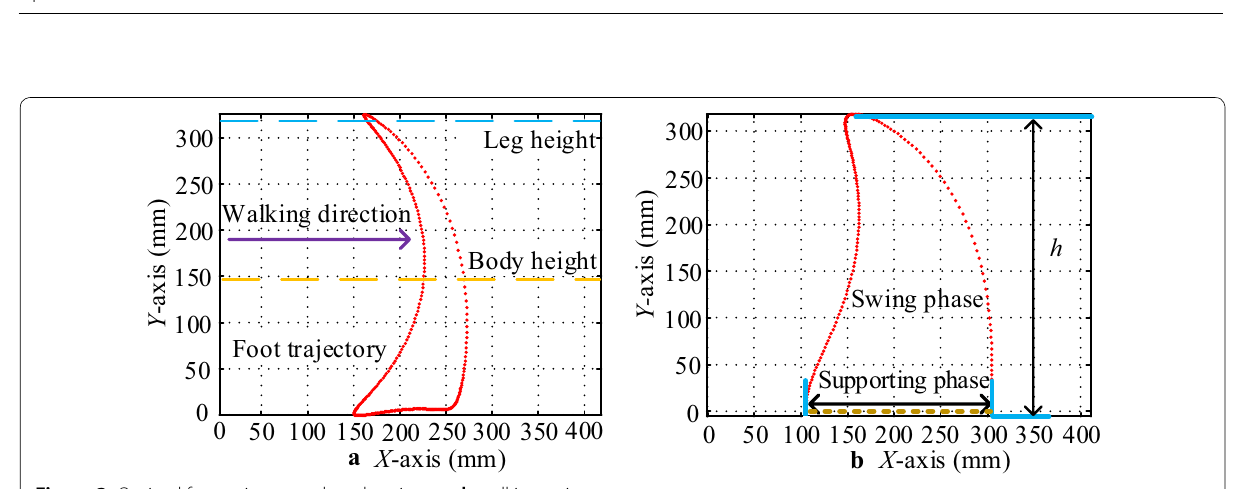
Figure 3 Optimal foot trajectory: a bench trajectory, b walking